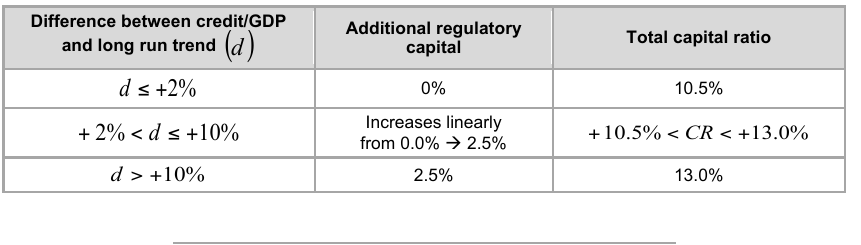
Proposed Basel III countercyclical rules